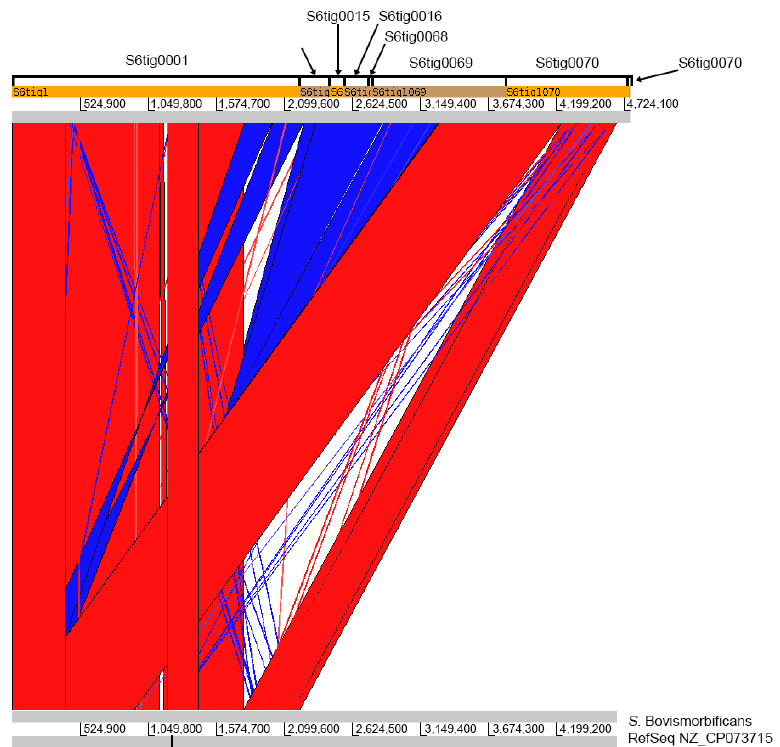
Figure 5. Comparison of the sequences from setting S6 against the reference genome. The contigs are detailed above the query line. Red and blue lines indicate forward and reverse matches, respec- tively.